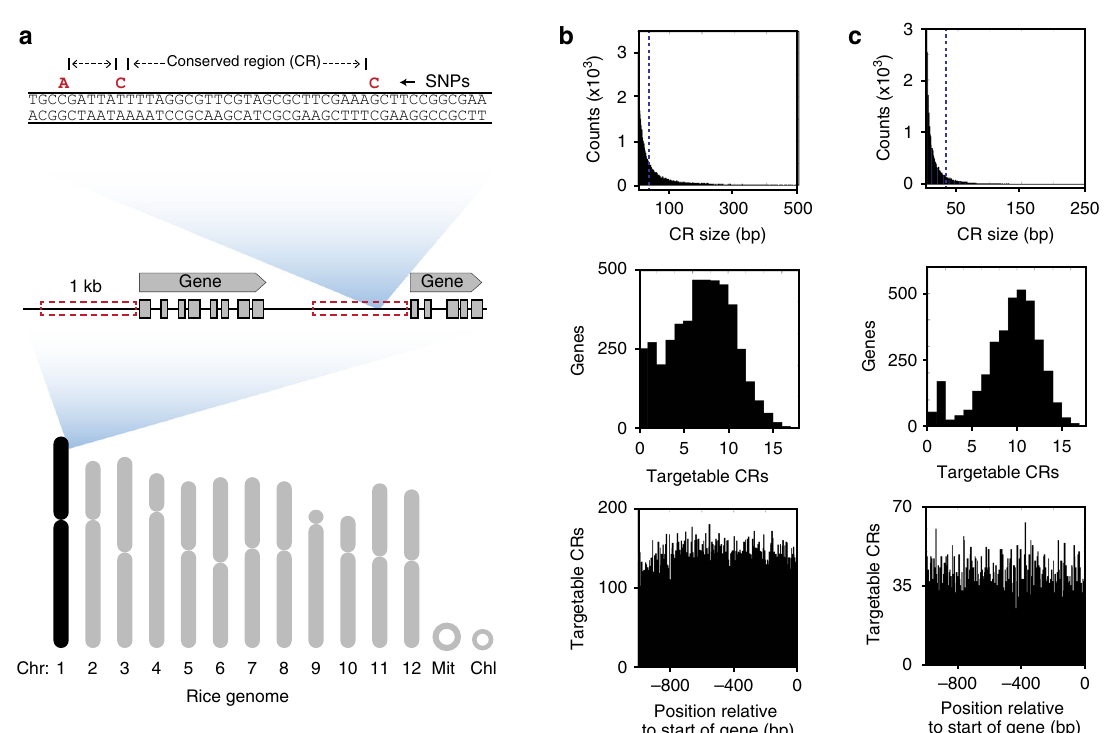
Fig. 3 Promoter sequence diversity analysis in rice and fruit fl ies. a Schematic represenation of rice chromosome with illustration of SNP-free conserved region (CR) identi fi cation. Red box denotes 1 kb upstream of annotated genes from Chr1 in the Oryza sativa Nipponbare genome. b Number of conserved regions versus size is shown for all SNP-free conserved sequences in promoter regions of Chr1 (top, n = 65,500 CRs). Also shown are targetable CRs (de fi ned as those larger than 30 bp) per promoter region (middle, n = 4487 genes), and the relative position of these targetable sequences relative to the start of the annotated gene ( ’ 0 ’ ) (bottom). c Equivalent data as in b , but for chromosome 2L from Drosophila melanogaster . (Total CRs in top panel = 215,705, total genes in middle panel = 3486). Spike at x = 1 for middle histograms is partially due to the counting of SNP-less promoters (entire 1 kb with no SNPs) as having a single